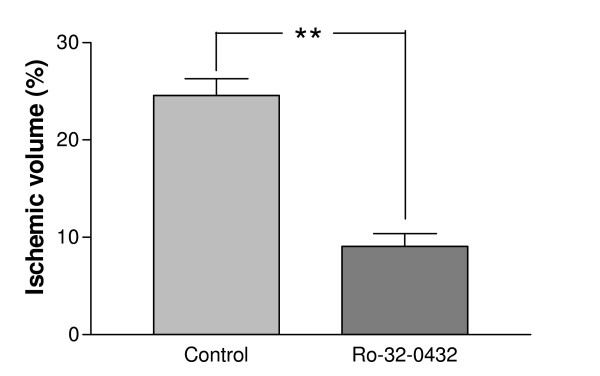
Ischemic infarction volume (% of total brain volume) in rats after MCAO in conjuction with treatment with vehicle (control) or Ro-32-0432. The PKC inhibition resulted in significantly smaller infarction volumes. Values represent means % ± S.E.M %, n = 4–6 (**P < 0.01).